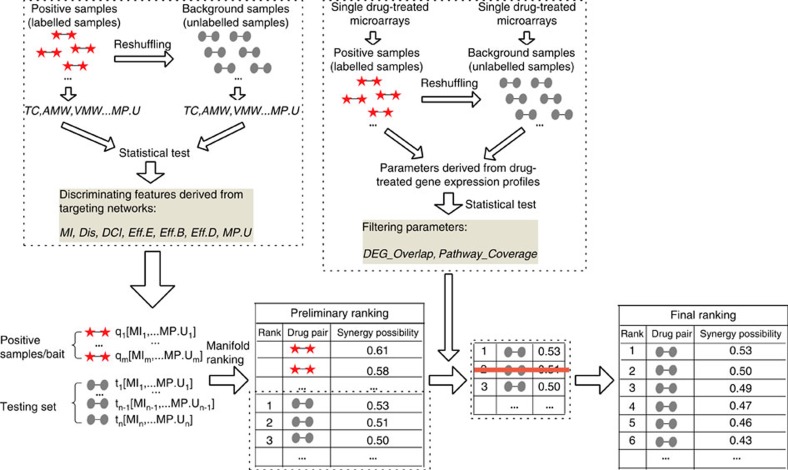
Workflow for RACS.The pairs of red stars denote the known synergistic drug pairs (labelled pairs), while the pairs of gray ellipses denote the unlabelled pairs. For any testing drugs provided by users, the household positive pairs are incorporated as baits into the data set. All the bait pairs and unlabelled testing pairs will be ranked via manifold-ranking method in the space of multiple features. After removing the baits, the preliminary ranking will be further refined by the gene expression filters.